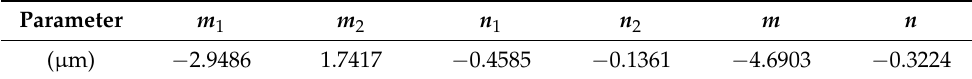
Table 3. The related parameters.